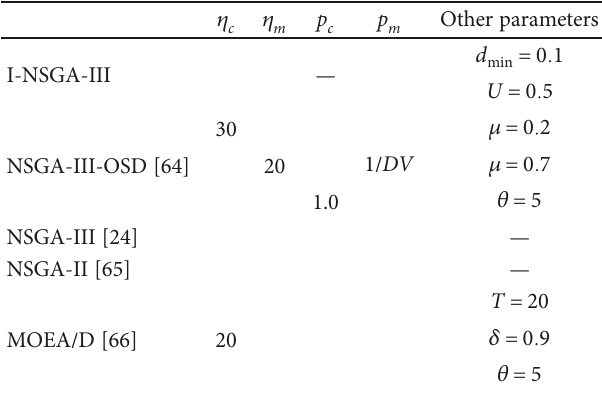
Table 8: Parameter setting of each